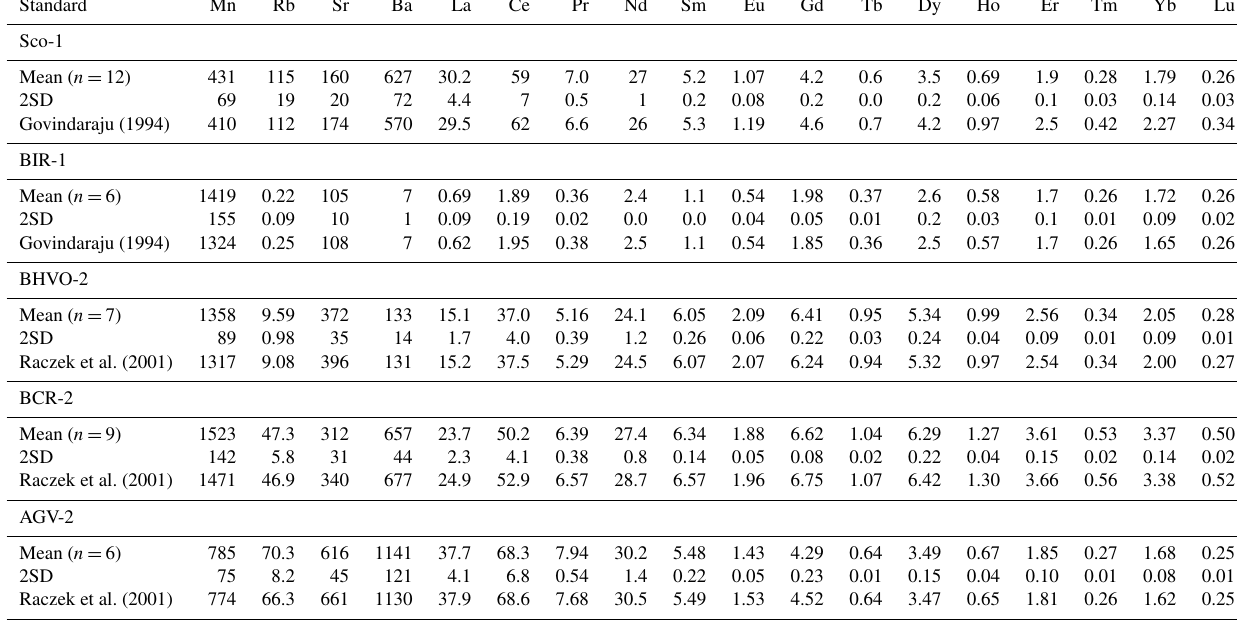
Table A3. Measurements of four USGS standards by ICP-OES compared to certificate values. Standard SiO 2 Al 2 O 3 Fe 2 O 3 TiO 2 MgO CaO Na 2 O K 2 O P 2 O 5 LOI wt% wt% wt% wt% wt% wt% wt% wt% wt% wt% SGR-1b Mean ( n = 8) 2SD 0.4 0.0 Ref. value G-2 Mean ( n = 2) 2SD Ref. value 69.1 BCR-2 Mean ( n = 4) 2SD 0.3 Ref. value 54.1 AGV-2 Mean ( n = 2) 58.5 ∗ 2SD 0.4 0.2 0.1 0.0 Ref. value